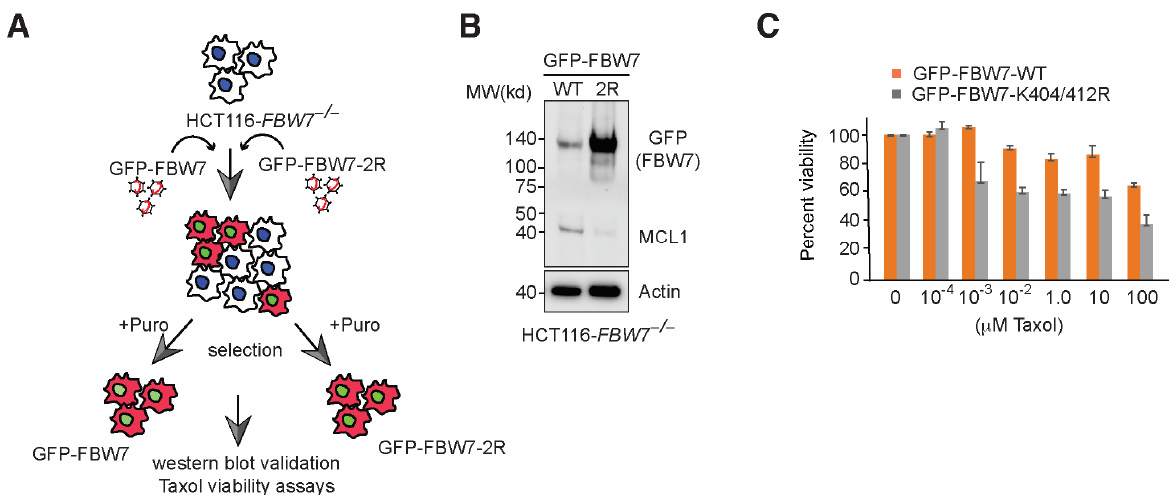
Figure 5. FBW7 K404/412R mutant reduces MCL ‐ 1 protein and sensitize HCT116 ‐ FBW7 − / − cells to Taxol. ( A ) Schematic of generation of FBW7 wildtype and K404/412R mutant cell lines. ( B ) Im ‐ munoblot showing FBW7 K404/412R stability and downregulation of MCL ‐ 1 in HCT116 ‐ FBW7 − / − cells in comparison to wild type controls. ( C ) Cell titer blue viability assay quantification from HCT116 ‐ FBW7 − / − overexpressing FBW7 wild type and 2R mutant cells treated with increasing doses of Taxol. Mean of 3 independent experiments is shown as percent viability.